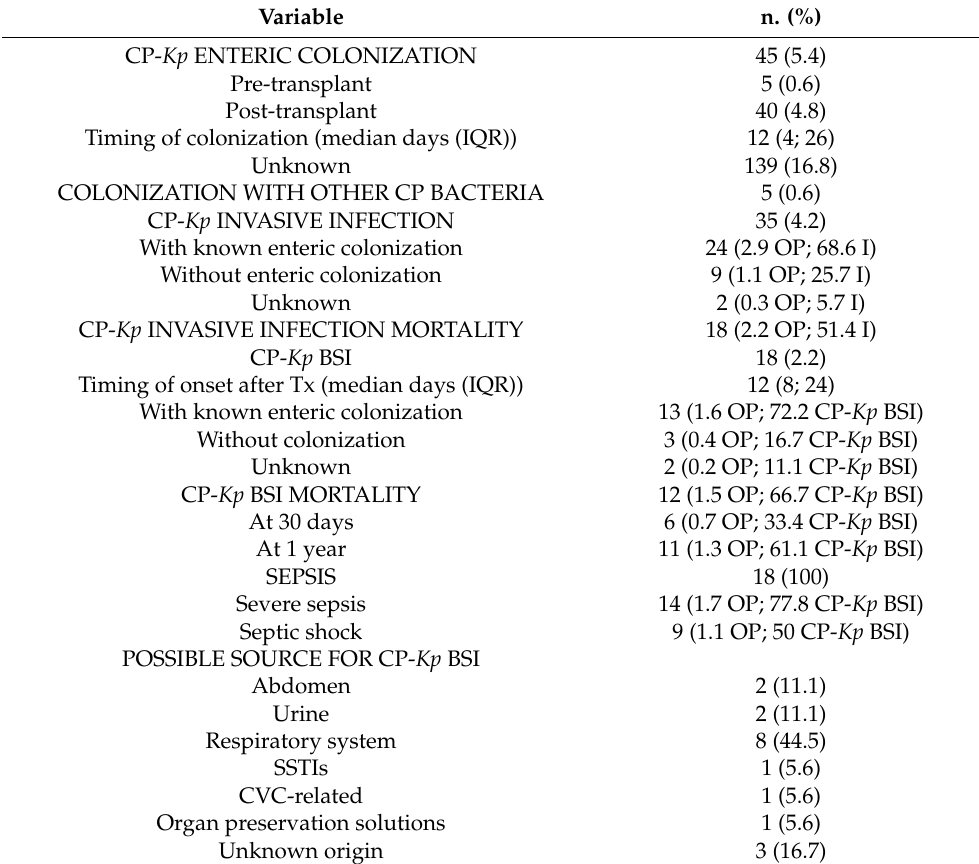
Table 2. Characteristics and outcomes of enteric colonization, organ infection, and bloodstream infection